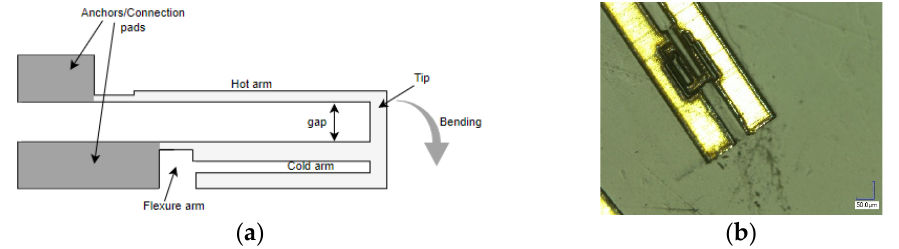
Figure 23. Modified version of design E having cold arm with a passive fin structure: ( a ) schematic diagram; ( b ) laser cut-out of the corresponding actuator.